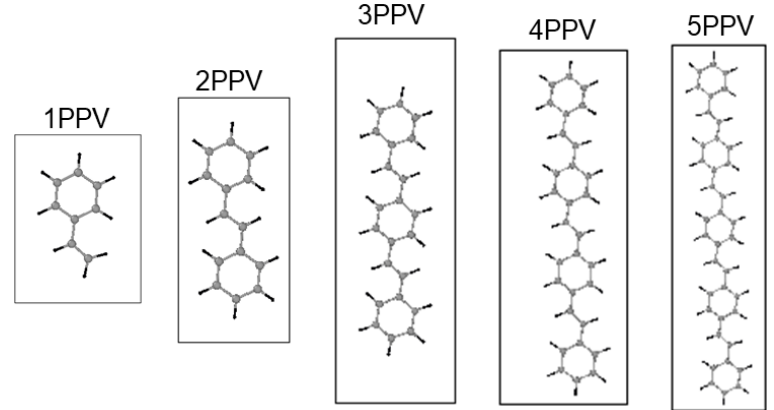
Figure 1. Poly (para-phenylene-vinylene) (PPV) oligomers and their designated names in this work.